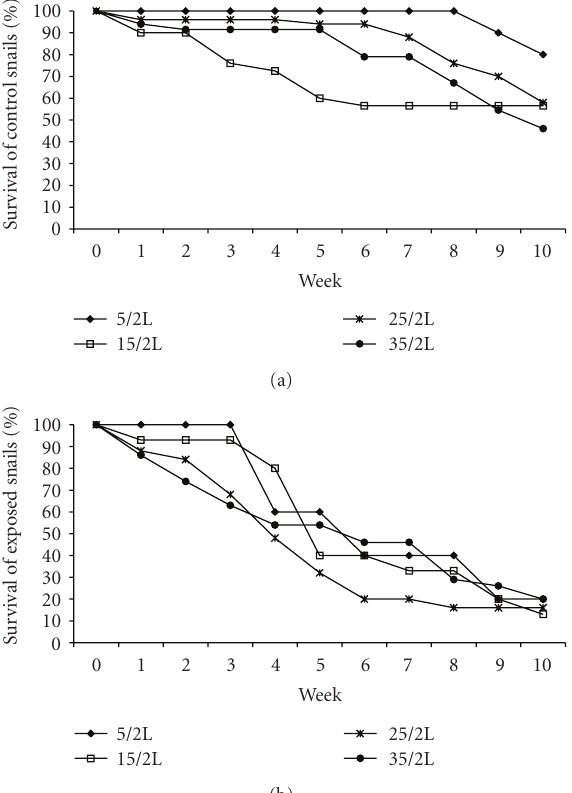
Figure 1: Mean percentage survival of unexposed snails (a) and snails exposed to miracidia (b). Values refer to the mean combined survival rates of snails in each treatment group. There was no significant di ff erence between the replicates of each treatment group.